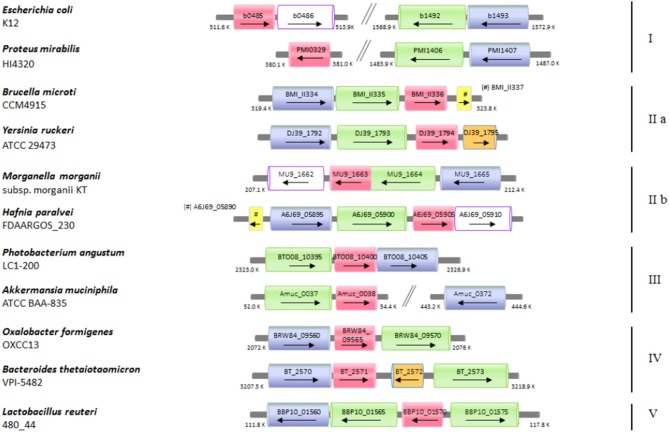
Schematic representation of the distribution of the genes coding for ybaS/glsA, gadB, and gadC in different bacterial genomes. Selected bacterial species and strains, where a potentially functional AR2_Q system occurs, are shown. The arrow lengths and the relative distances are proportional to the gene lengths and distances between adjacent genes, respectively. The corresponding locus tags are shown within each arrow. The homologous genes are represented in different colors: ybaS/glsA, in magenta; gadC, in green; gadB, in blu; ybaT, in white with violet contour; hdeA/B (periplasmic chaperone) in yellow; putative potassium channel, in orange. The genes with putative functions are dashed in the same color as that of the genes with an assigned function.